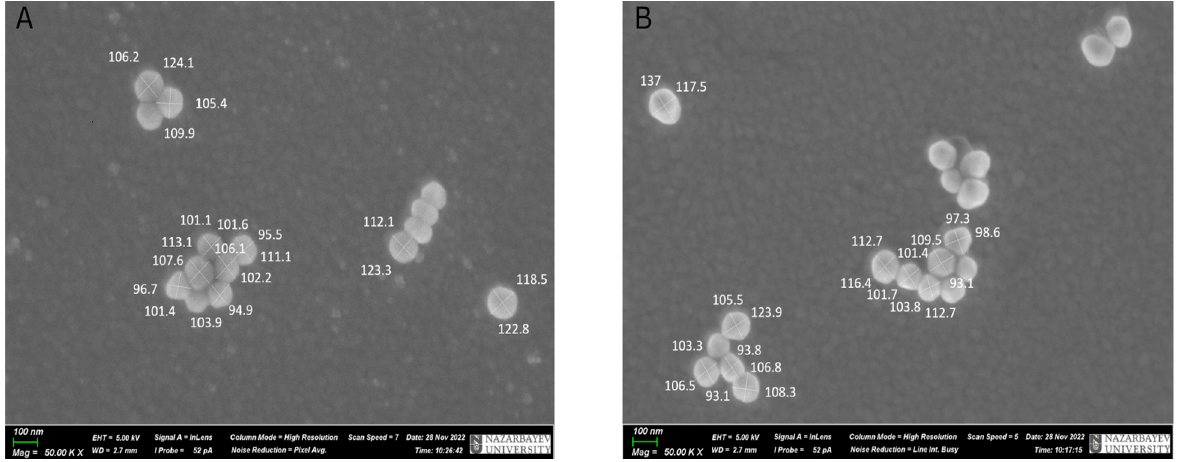
Figure 2. SEM pictures of 100 nm Ag NPs and 100 nm Au NPs on the silver substrates. ( A ) The SEM image of 100 nm Ag NPs with a magnification of 50,000. ( B ) The SEM image of 100 nm Au NPs with a magnification of 50,000.